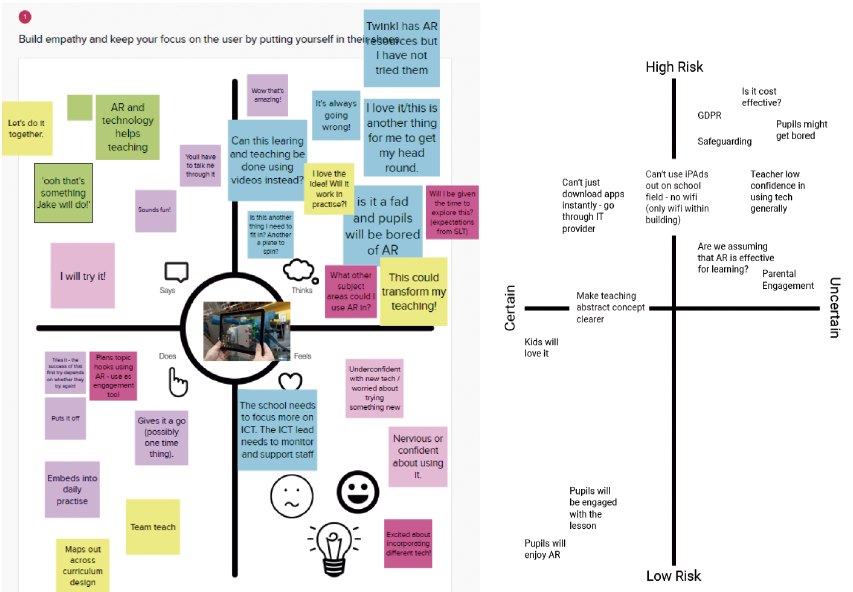
Figure 3. Empathy Canvas Map & Assumption Grid (Design